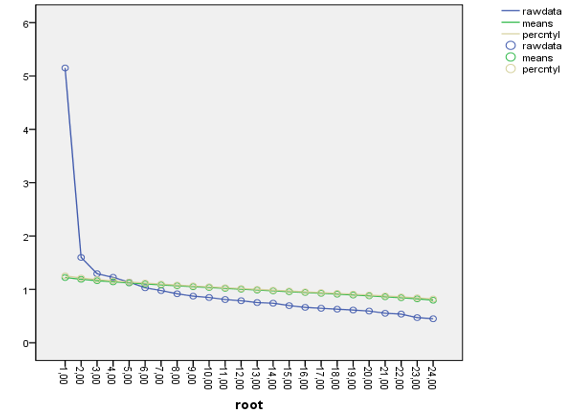
Figure 1 . Scree Plot of Social Compe-